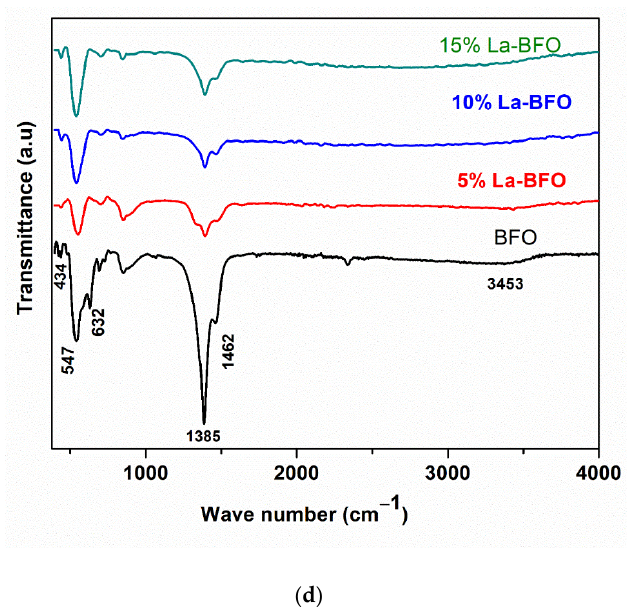
Figure 1. ( a ) XRD pattern of BFO, 5% La-BFO, 10% La-BFO and 15% La-BFO. Insert: enlarged view from 2θ 25– 40°; ( b ) FESEM images of BFO; ( c ) EDS of 10% La-BFO; and ( d ) FTIR spectra of BFO, 5% La-BFO, 10% La-BFO and 15% La-BFO.